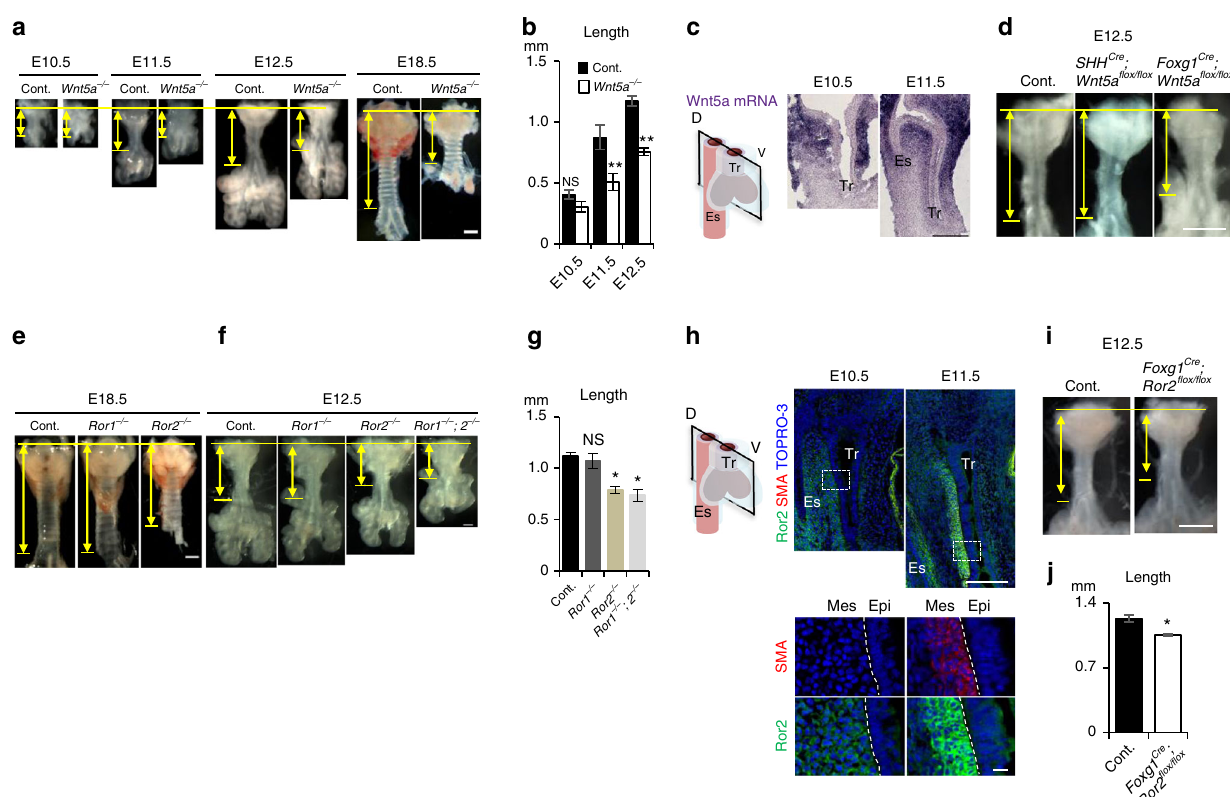
Fig. 3 Wnt5a-Ror2 signaling is involved in tube elongation. a Gross morphology of a developing Wnt5a − / − trachea and littermate control. b Tracheal tube length (control; n = 4 – 6, Wnt5a − / − ; n = 3). c In situ hybridization for Wnt5a mRNA in developing tracheas. d Gross morphology of Foxg1 Cre ; Wnt5a fl ox/ fl ox trachea ( n = 4), SHH Cre ; Wnt5a fl ox/ fl ox ( n = 3) trachea, and littermate control ( n = 7) at E12.5. Gross morphology of Ror1 and/or 2 − / − trachea and littermate control at E18.5 ( e ) and 12.5 ( f ). g Tracheal tube length (control; n = 4, Ror1 − / − = 5, Ror2 − / − = 5, Ror1 − / − ; Ror2 − / − = 3). h Ror2 and SMA expression in developing tracheas. Sections were stained for Ror2 (green), SMA (red), and TOPRO-3 (blue). Lower panels show higher magni fi cation images of dotted squares. Dotted lines indicate epithelium – mesenchyme boundary. i Gross morphology of Foxg1 Cre ; Ror2 fl ox/ fl ox trachea and littermate control at E12.5. j Tracheal tube length (control; n = 5, Foxg1 Cre , Ror2 fl ox/ fl ox ; n = 9). Yellow arrows indicate trachea length. D dorsal; V ventral; Epi epithelium; Mes mesenchyme; Tr trachea; Es esophagus. P values ( * P < 0.05, ** P < 0.01) show the signi fi cance with Student ’ s t test ( b ) or the Tukey-Kramer